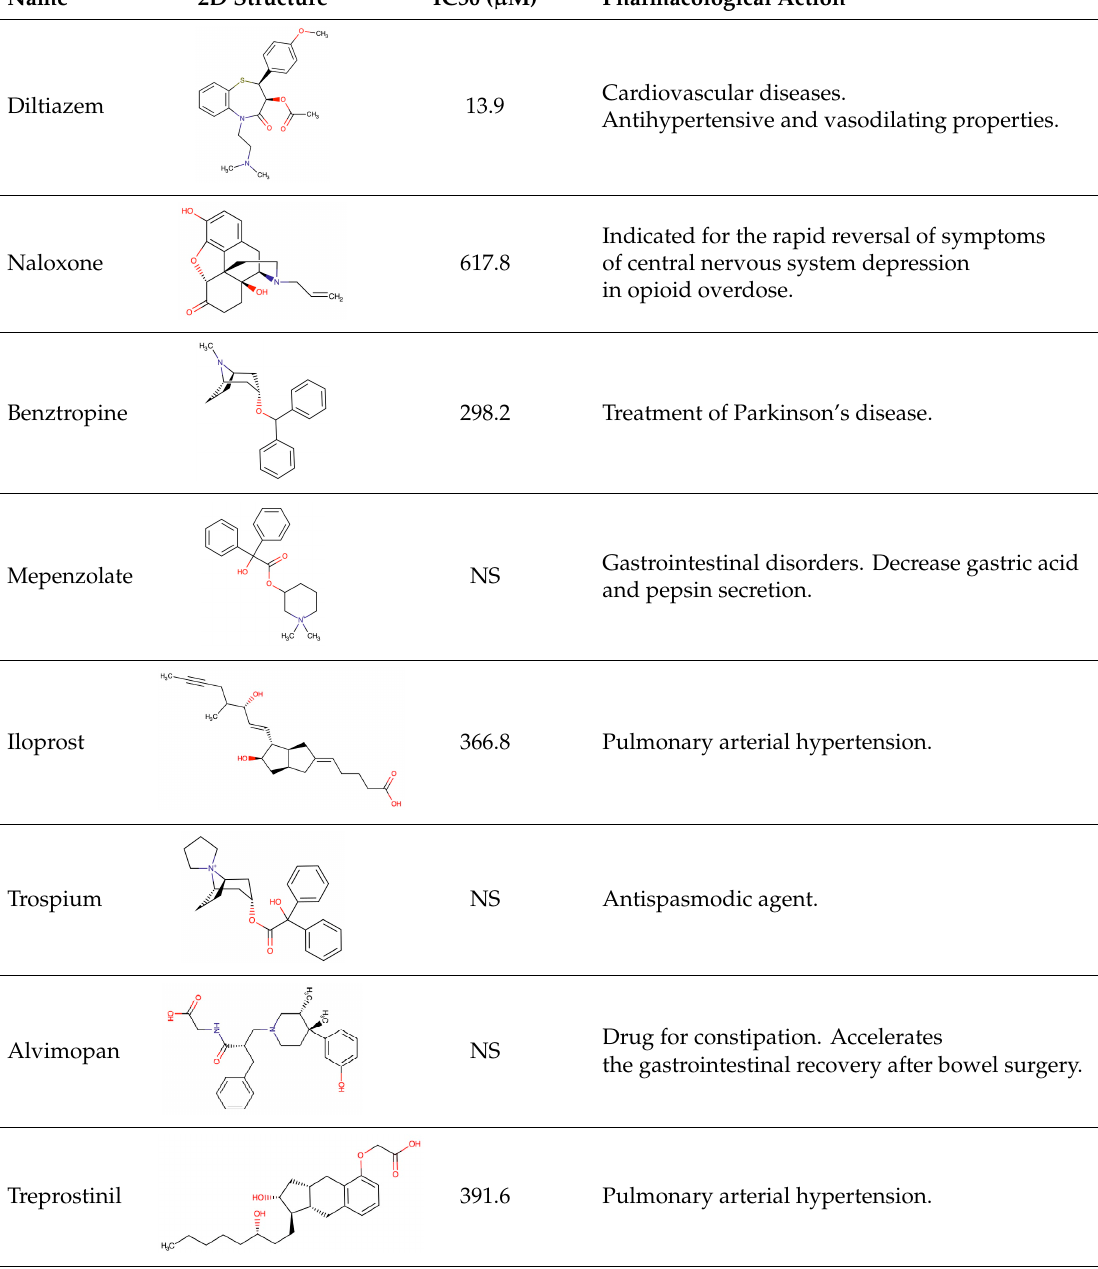
Table 2. Name, 2D structure, IC50, and pharmacological action of the eight drugs tested in vitro on a CES1 assay. NS means Non-significant.